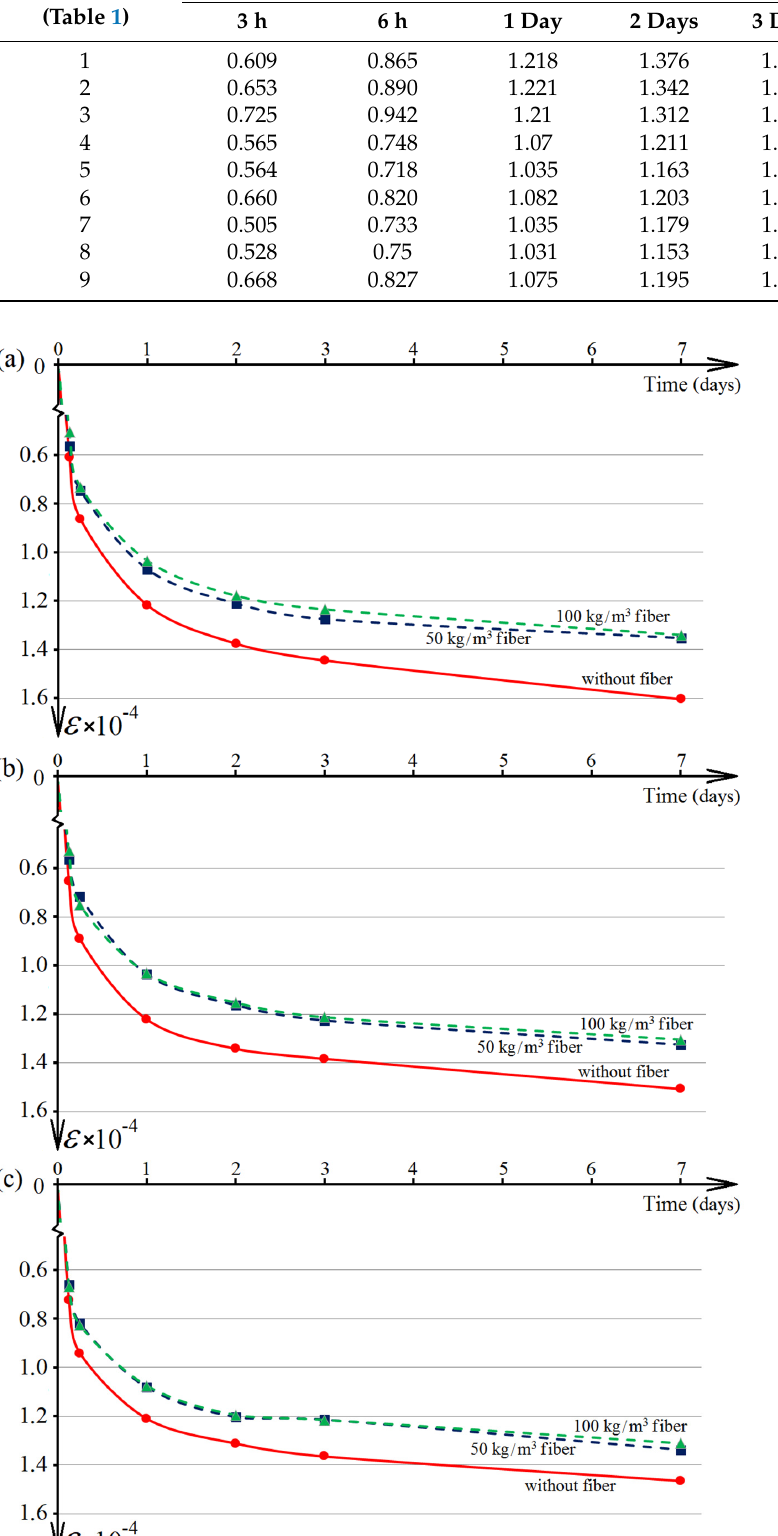
Figure 8. Shrinkage ratio of investigated fiber-concretes (Table 6) during hardening in air-dry